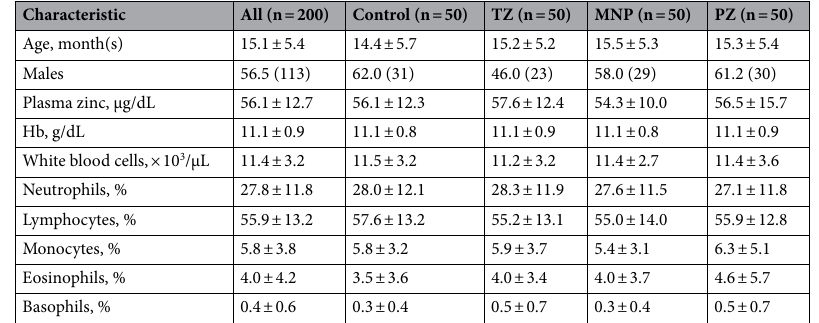
Table 1. Baseline characteristics of the total study population (All) and each intervention group. The values are the mean ± standard deviation or % (n). Control, placebo; TZ therapeutic dispersible zinc tablets, MNP